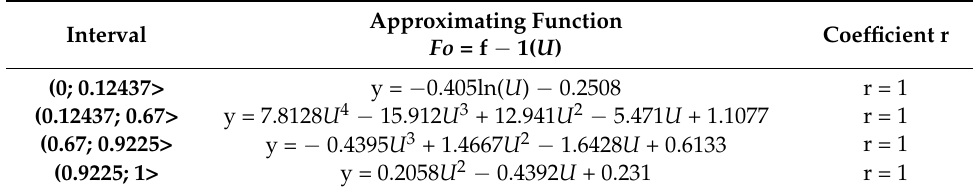
Table 2. Intervals and functions approximating Fo